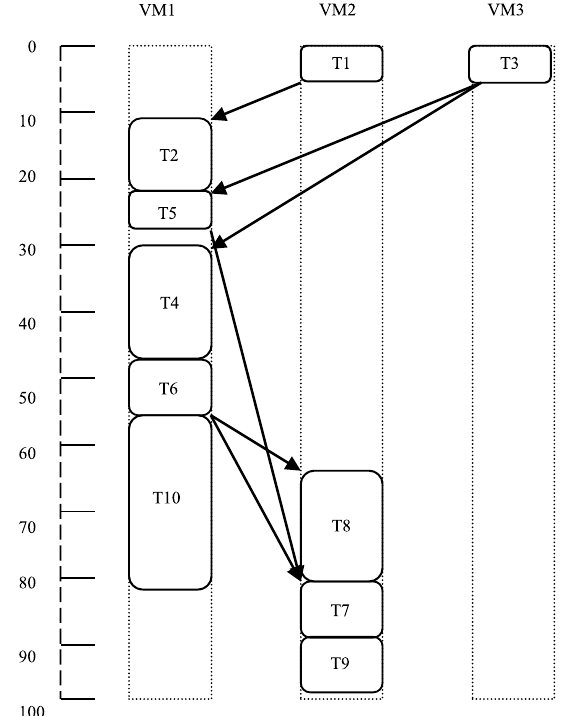
Fig.4 Scheduling of DAG with original HEFT algorithm. (Use of Average Computation Cost in Rank Calculation & Schedule length is 98)